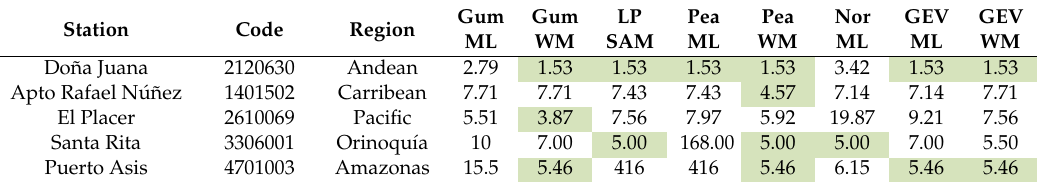
Table 3. Values of chi-squared test for a sample of rainfall stations.